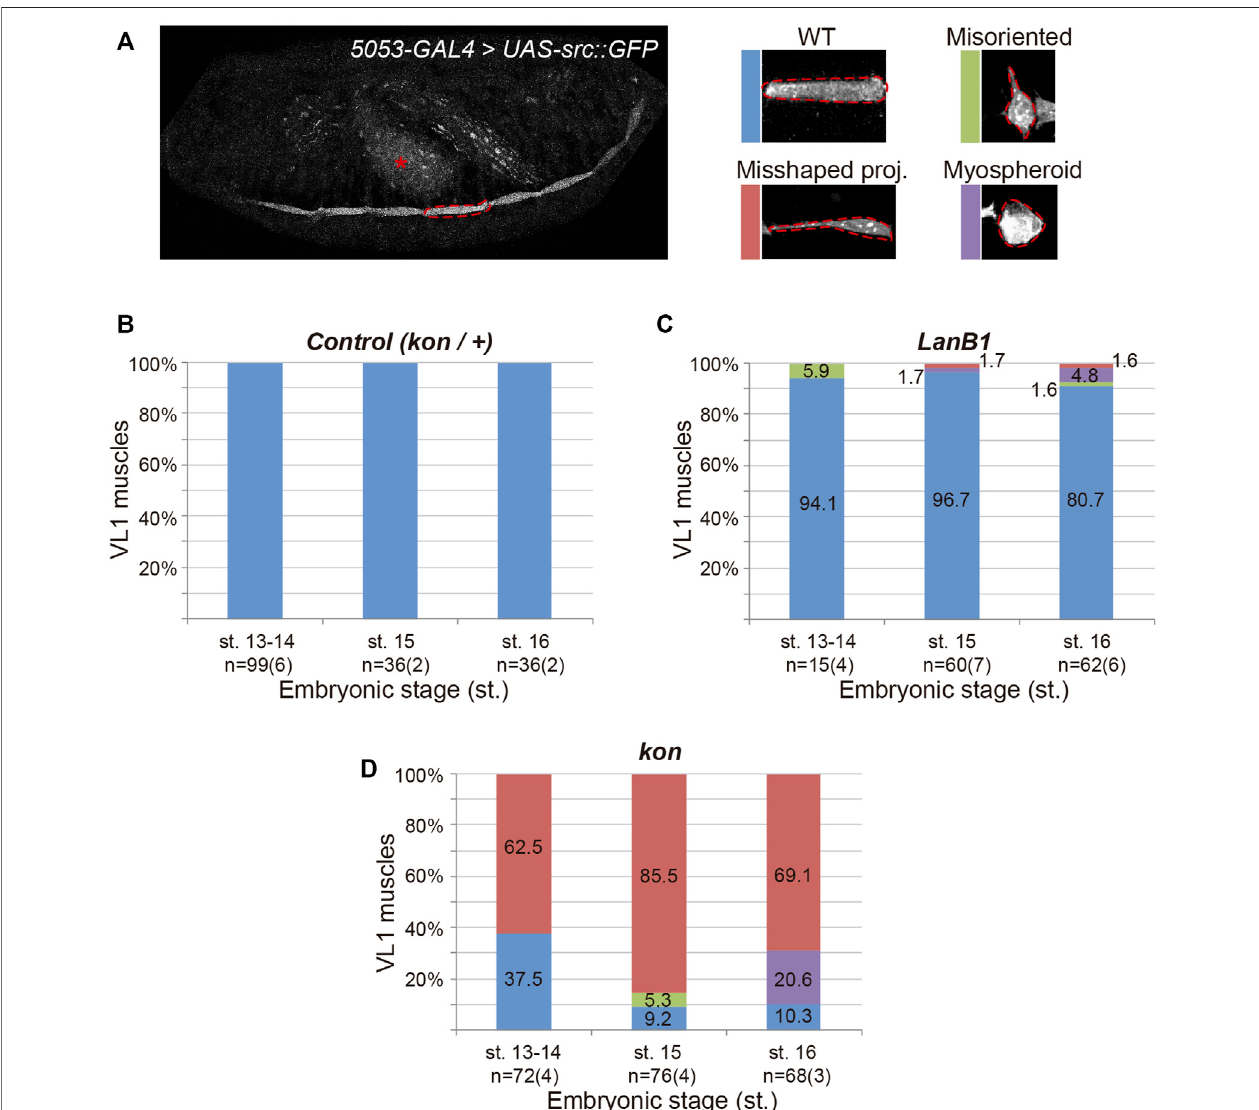
FIGURE 2 | Development of ventral-longitudinal muscle 1 (VL1). (A) Left panel shows a representative example of the confocal projection in a stage 16 embryo. 5053-GAL4 expressestheplasmamembranemarkersrc:GFPintheVL1muscleofeachsegment(dottedlineindicatesoneexample)andthegut(asterisk).Rightpanels show representative examples of the different morphological phenotypes observed in VL1 muscle for the genotypes indicated. (B – D) Quanti fi cation of the proportion of VL1 muscles according to their morphology at different embryonic stages for the indicated genotypes. Bar colors indicate VL1 muscle phenotypes: WT, blue; Misoriented, green; Misshaped projection,red; Myospheroid, purple. Samplesizeindicates thetotal number ofmusclesoverthenumberofembryos indicatedbetween parentheses.